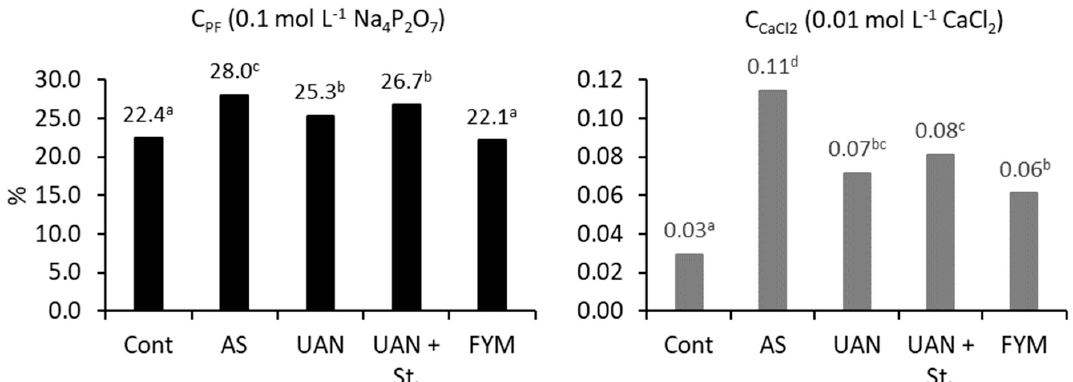
Figure 3. Ratio of extractable carbon of total soil organic matter carbon (C SOM ); topsoil; different letters behind the values mean significant differences among investigated treatments (Tukey test; p < 0.05); number of replications per treatment n = 4.